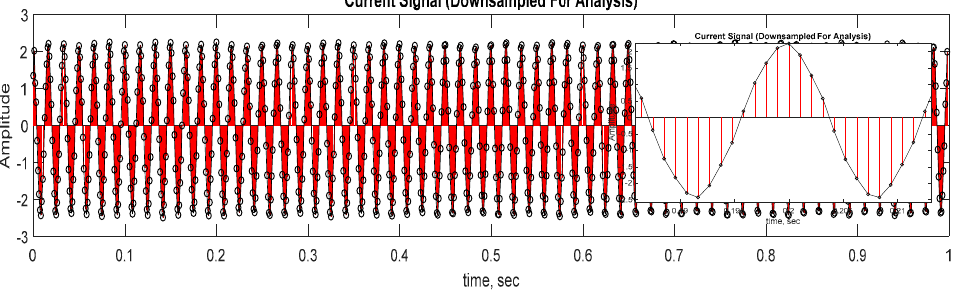
Figure 14. Downsampled current signal of measurement of motor line current of phase A at 60 Hz operation.